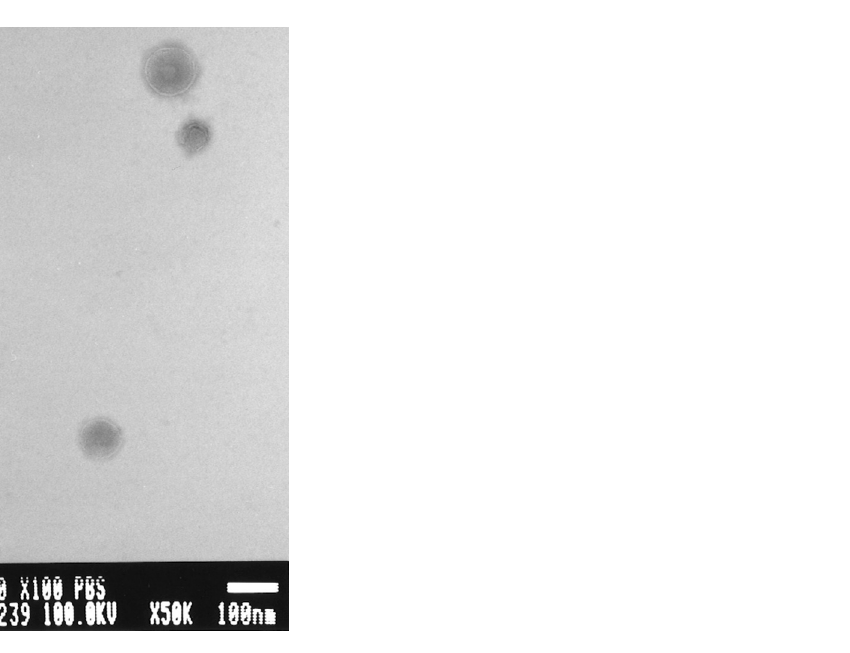
Table 1. Characteristics of PBL liposomes.